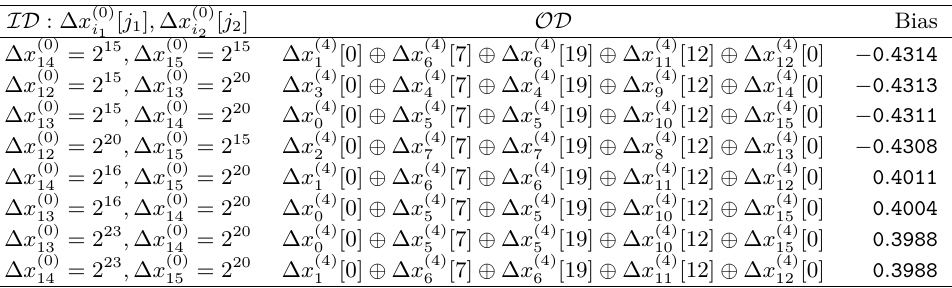
Table 7: Best second order 5-bit differentials for 4 rounds of ChaCha